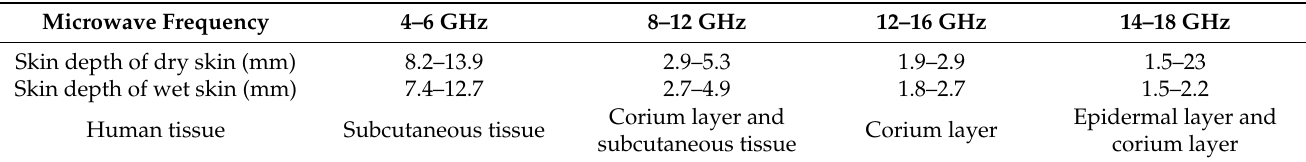
Table 1. The relationship between the frequency bands of the multiband noncontact thermometer and skin depth and human